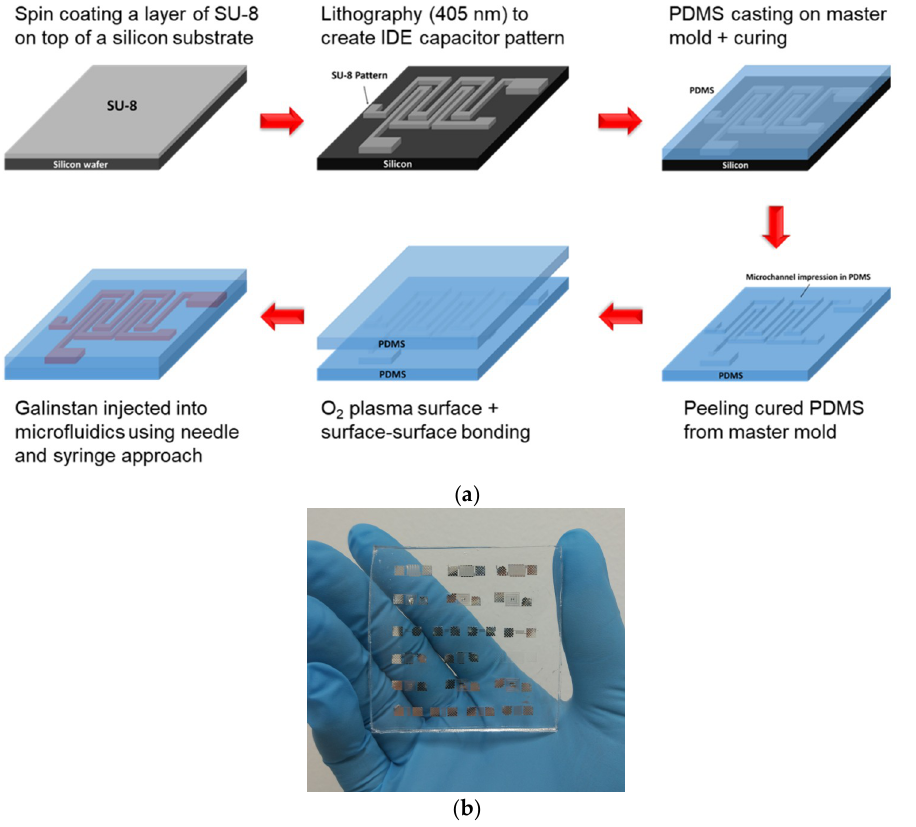
Figure 1. ( a ) Fabrication process flow of the soft IDE capacitor, and ( b ) photo image of the fabricated IDE soft capacitors of various sizes. The height of the liquid metal electrode was 100 µm.